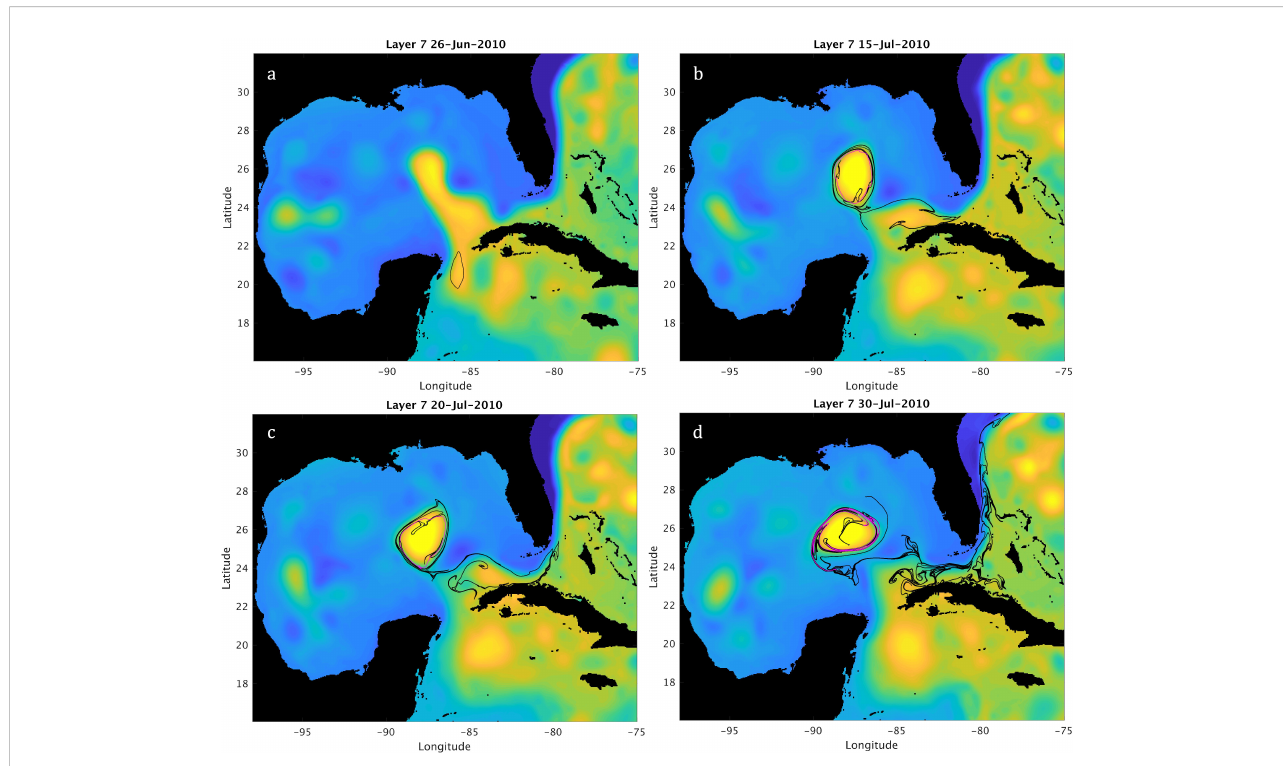
FIGURE 8 Snapshots of the evolution of the LCE boundary (magenta contours) and coherent anticyclonic boundary (black contours) detected south of the Yucatan Channel along with the, superimposed on model SSH for (A) June 26, 2010; day of coherent Caribbean anticyclonic boundary detection, (B) July 15, 2010; just after the LCE was detected coherent (magenta contours), and (C, D) 5 and 15 days later,